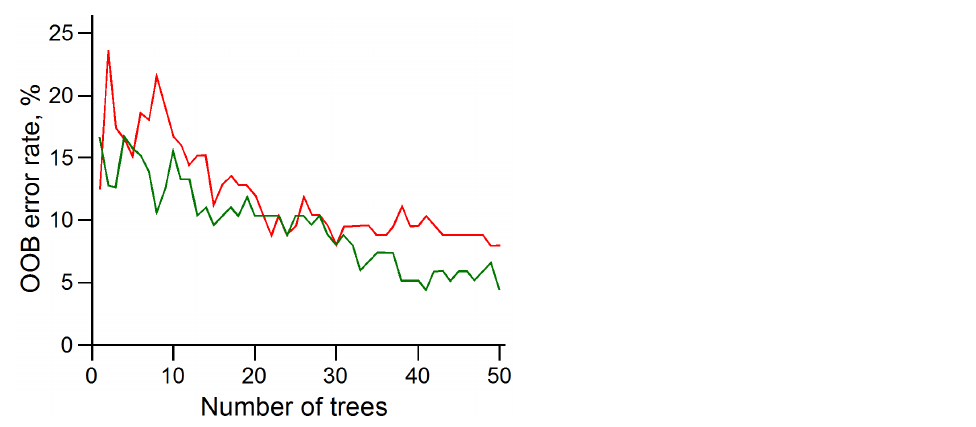
Figure 5. Evolution of the RFC error rate (OOB) with the increase in tree number ( ntree parameter) for H (red) and L (green)